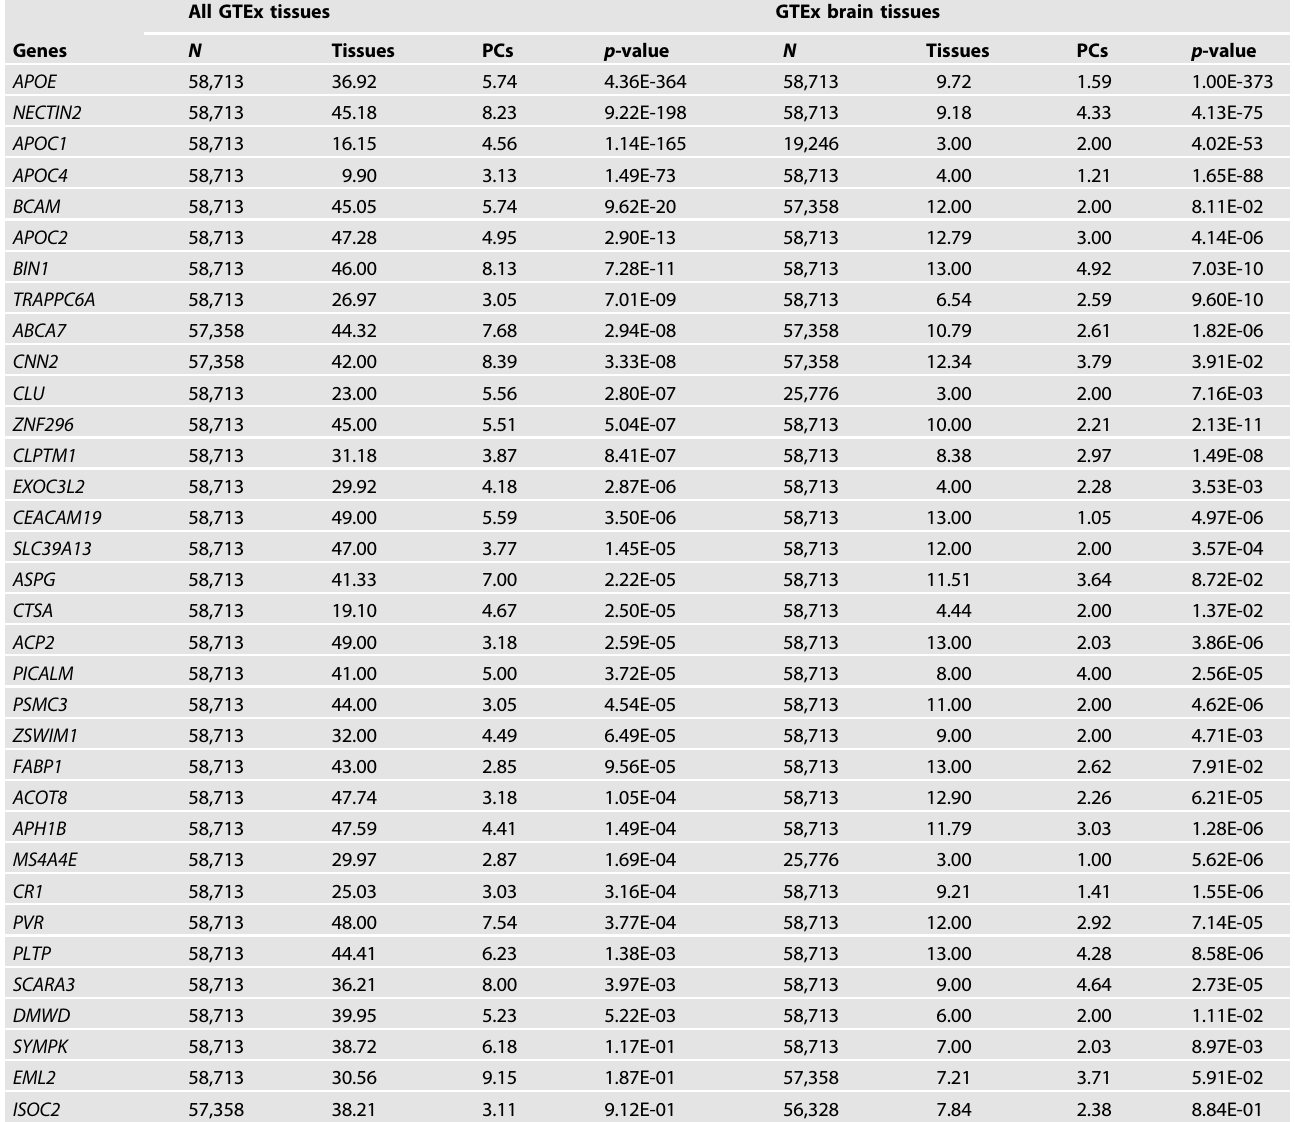
Table 3. The signi fi cant genes in cross-tissue